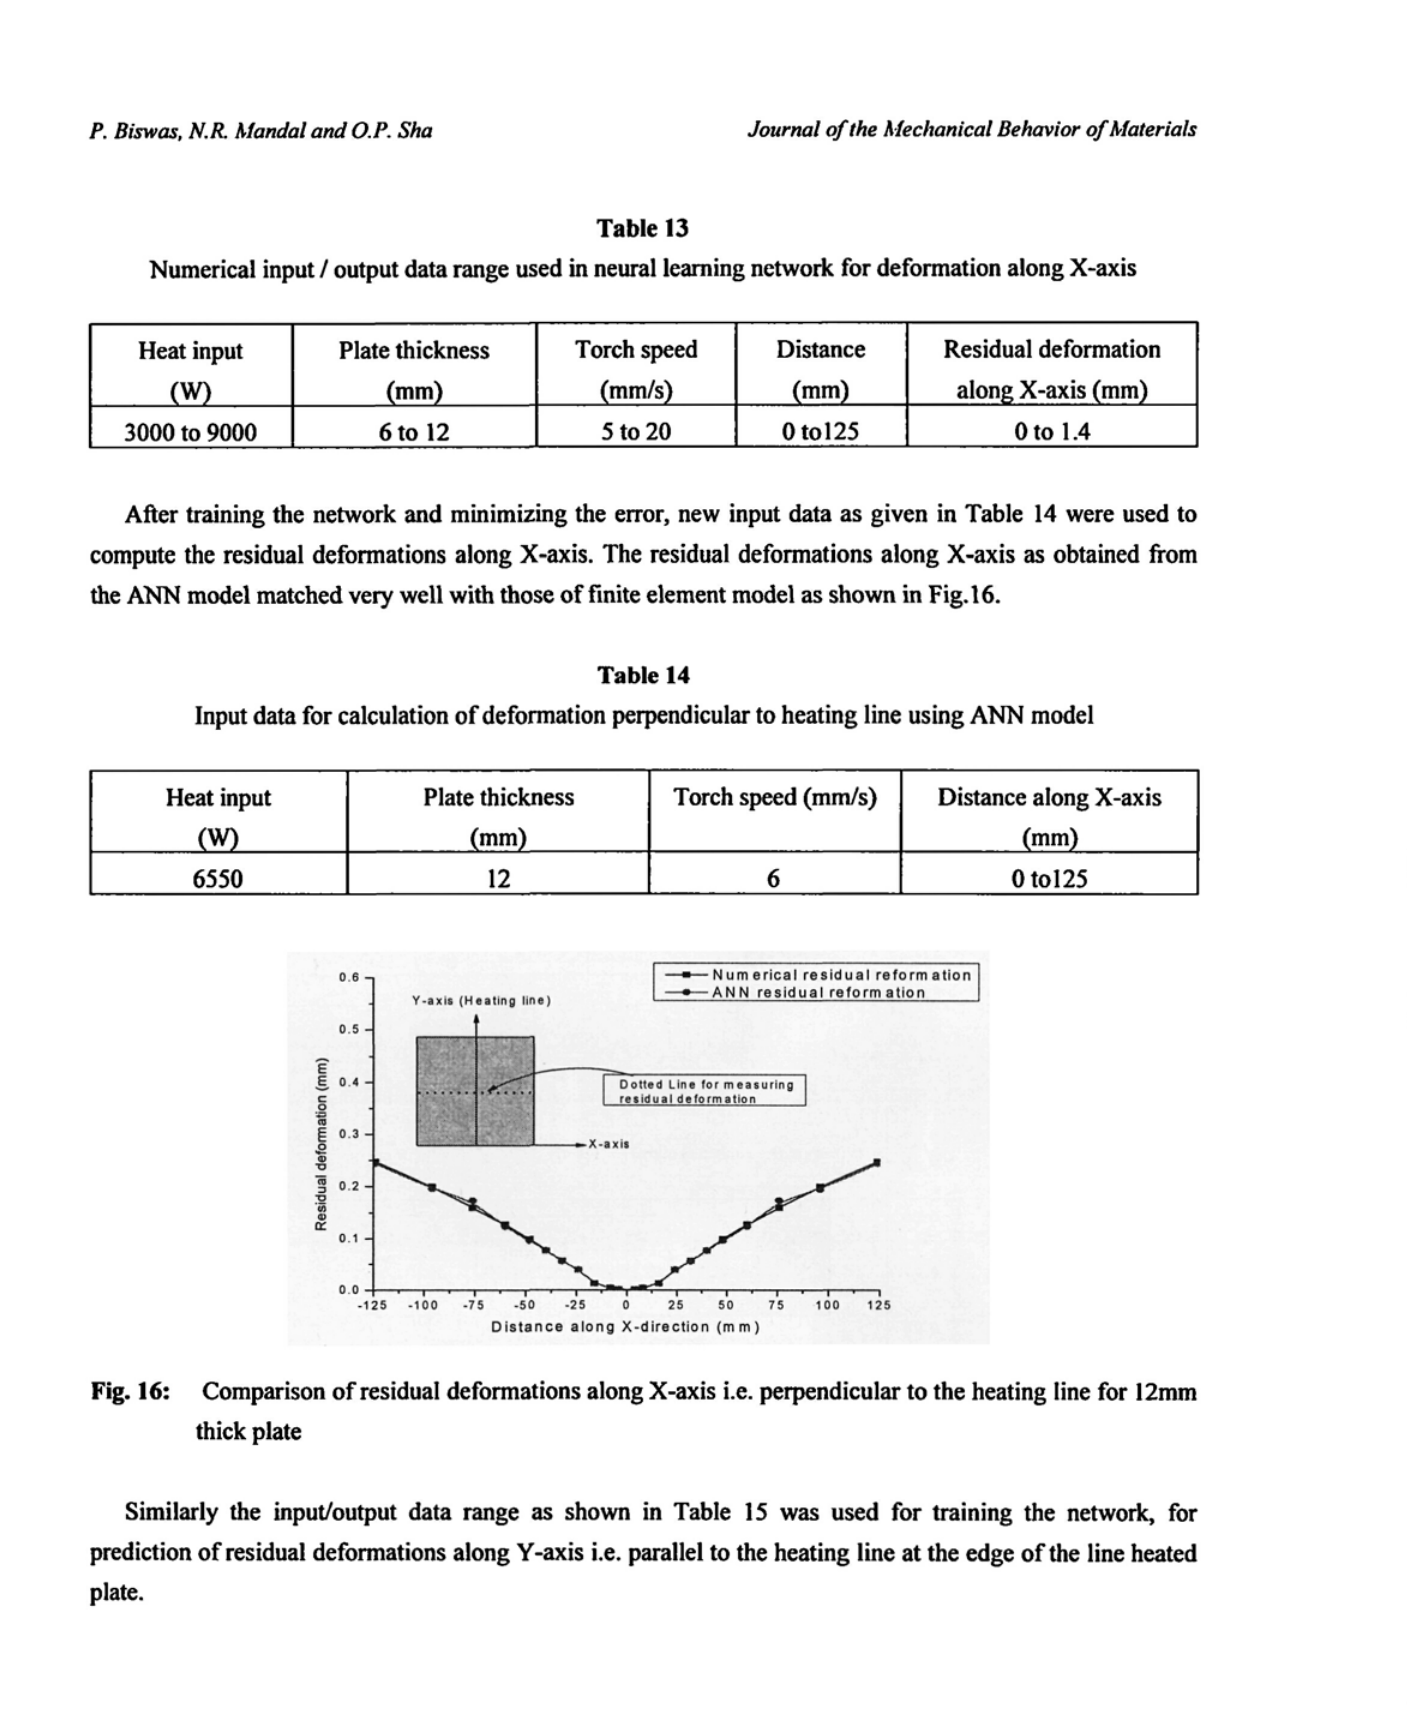
Numerical input / output data range used in neural learning network for deformation along X-axis